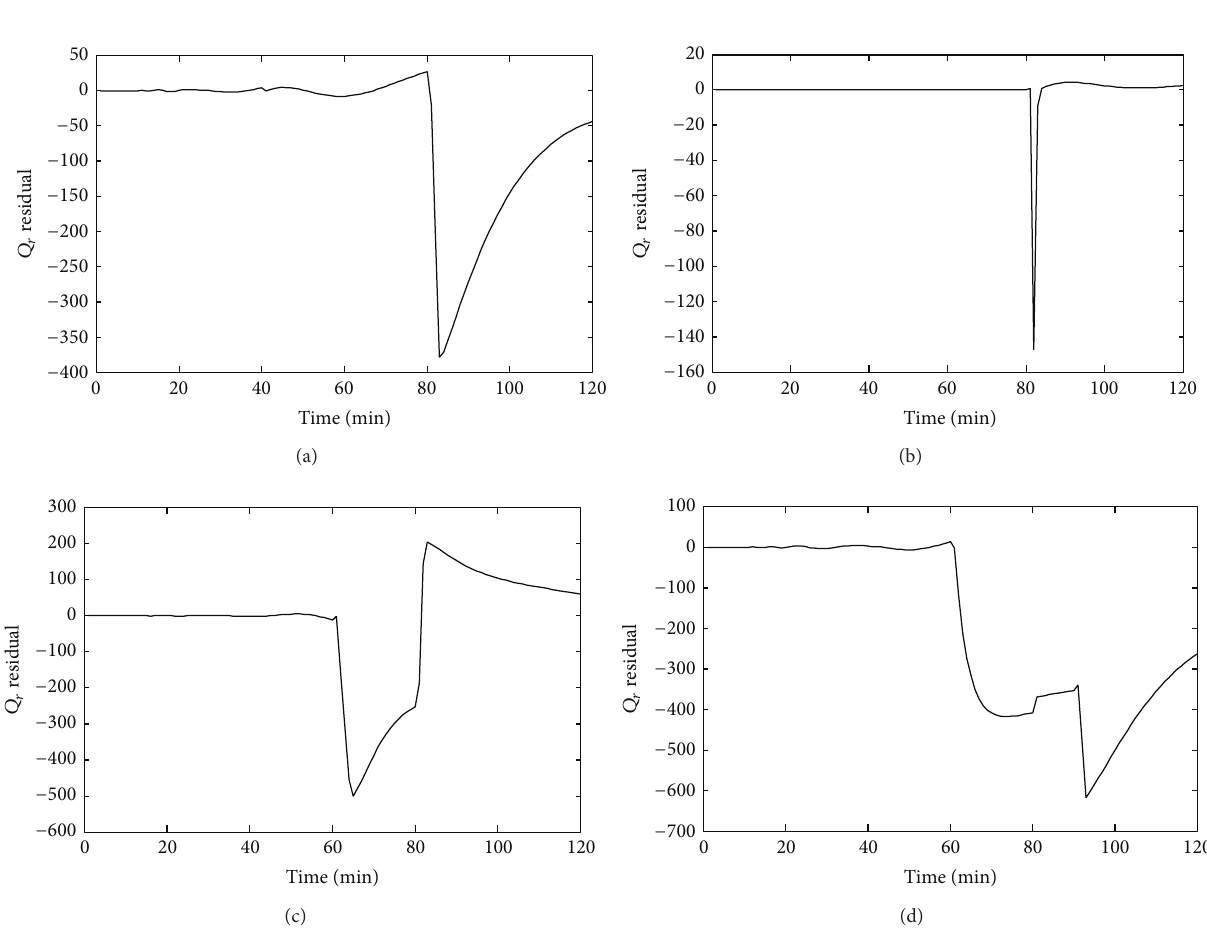
Figure 13: Residual (in terms of 𝑄 𝑟 ) due to actuator biasing at different intervals. (a) Residual (in terms of 𝑄 𝑟 ) due to actuator biasing at the time interval (80 min). (b) Residual (in terms of 𝑄 𝑟 ) due to actuator biasing at the time interval (80 min). (c) Residual (in terms of 𝑄 𝑟 ) due to actuator biasing at the time interval (60 min). (d) Residual (in terms of 𝑄 𝑟 ) due to actuator biasing at the time interval (90